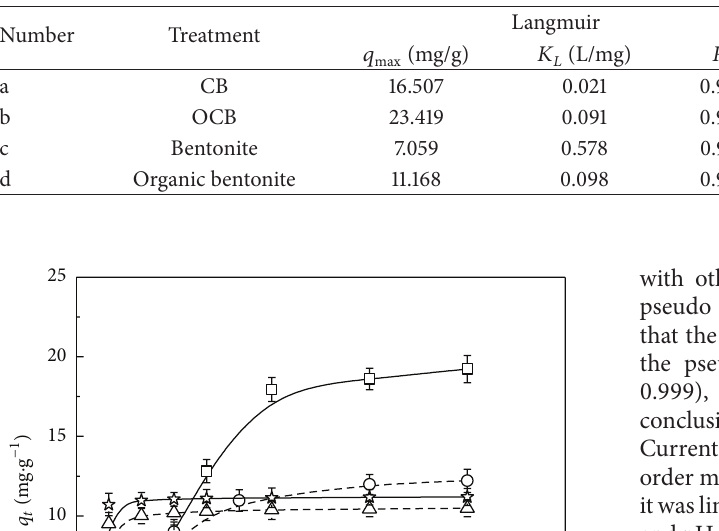
Table 3: Parameters for adsorption isotherm of Cu(II) on CB and bentonite.